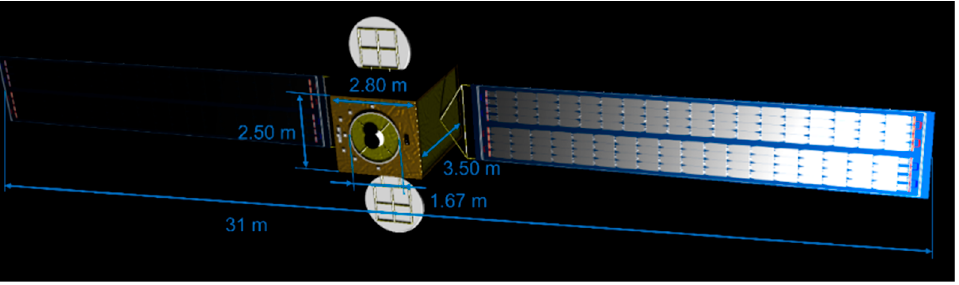
Figure 2. Target spacecraft model as developed in PANGU, with indication of the main dimensions.